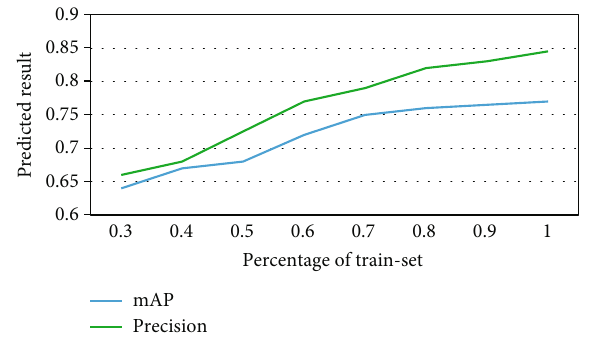
Figure 10: Using the kernel function, the e ff ect of the training set size on the experimental results of target